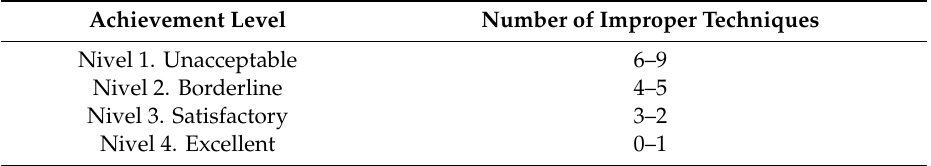
Table 4. Achievement levels according to the number of improper techniques or